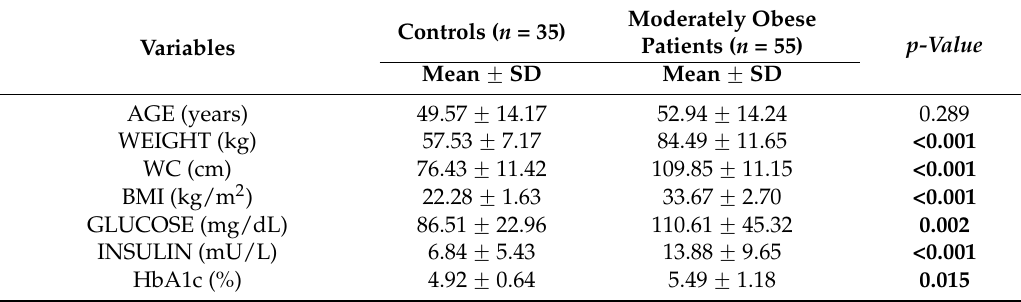
Table 1. Characteristics of the cohort